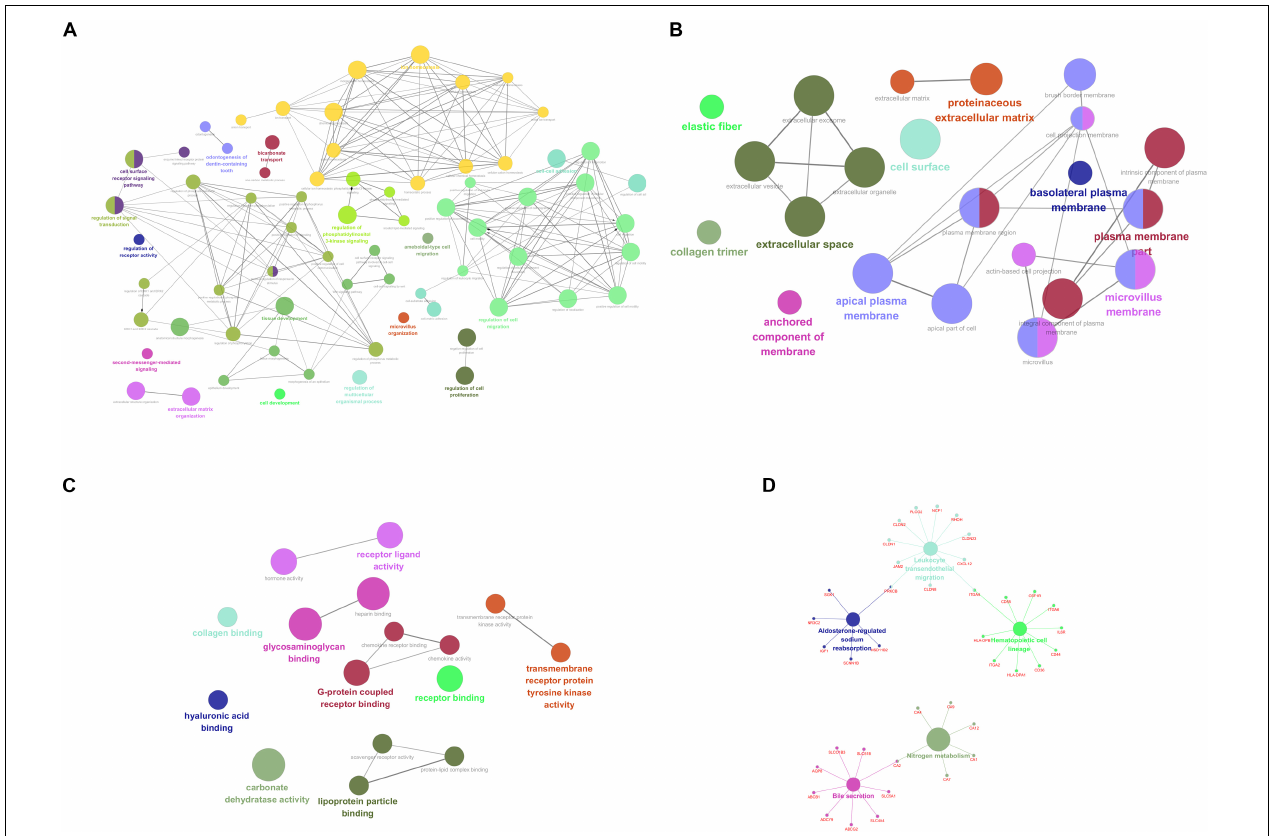
FIGURE 2 | Functionally enriched GO terms and KEGG pathways analysis of DEGs in colorectal adenoma. Each group is represented by only the label of the most significant term/pathway. A grouped network of functionally enriched genes generated for the DEGs using ClueGO. The node size indicates the term/pathway enrichment significance. Functionally associated groups partially overlap. (A) BP-associated category; (B) CC-associated category; (C) MF-associated category; (D) KEGG pathways. DEGs, differentially expressed genes; GO, Gene Ontology (GO); BP, biological processes; CC, cellular component; MF, molecular function; KEGG, Kyoto Encyclopedia of Genes and